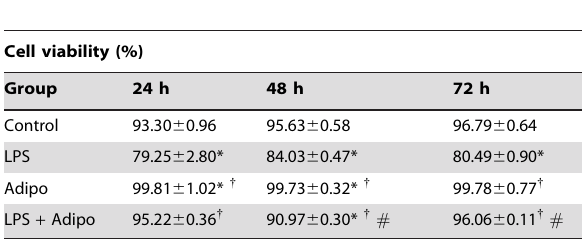
Table 2. Interactions of lipopolysaccharide and adiponectin on cell viability.